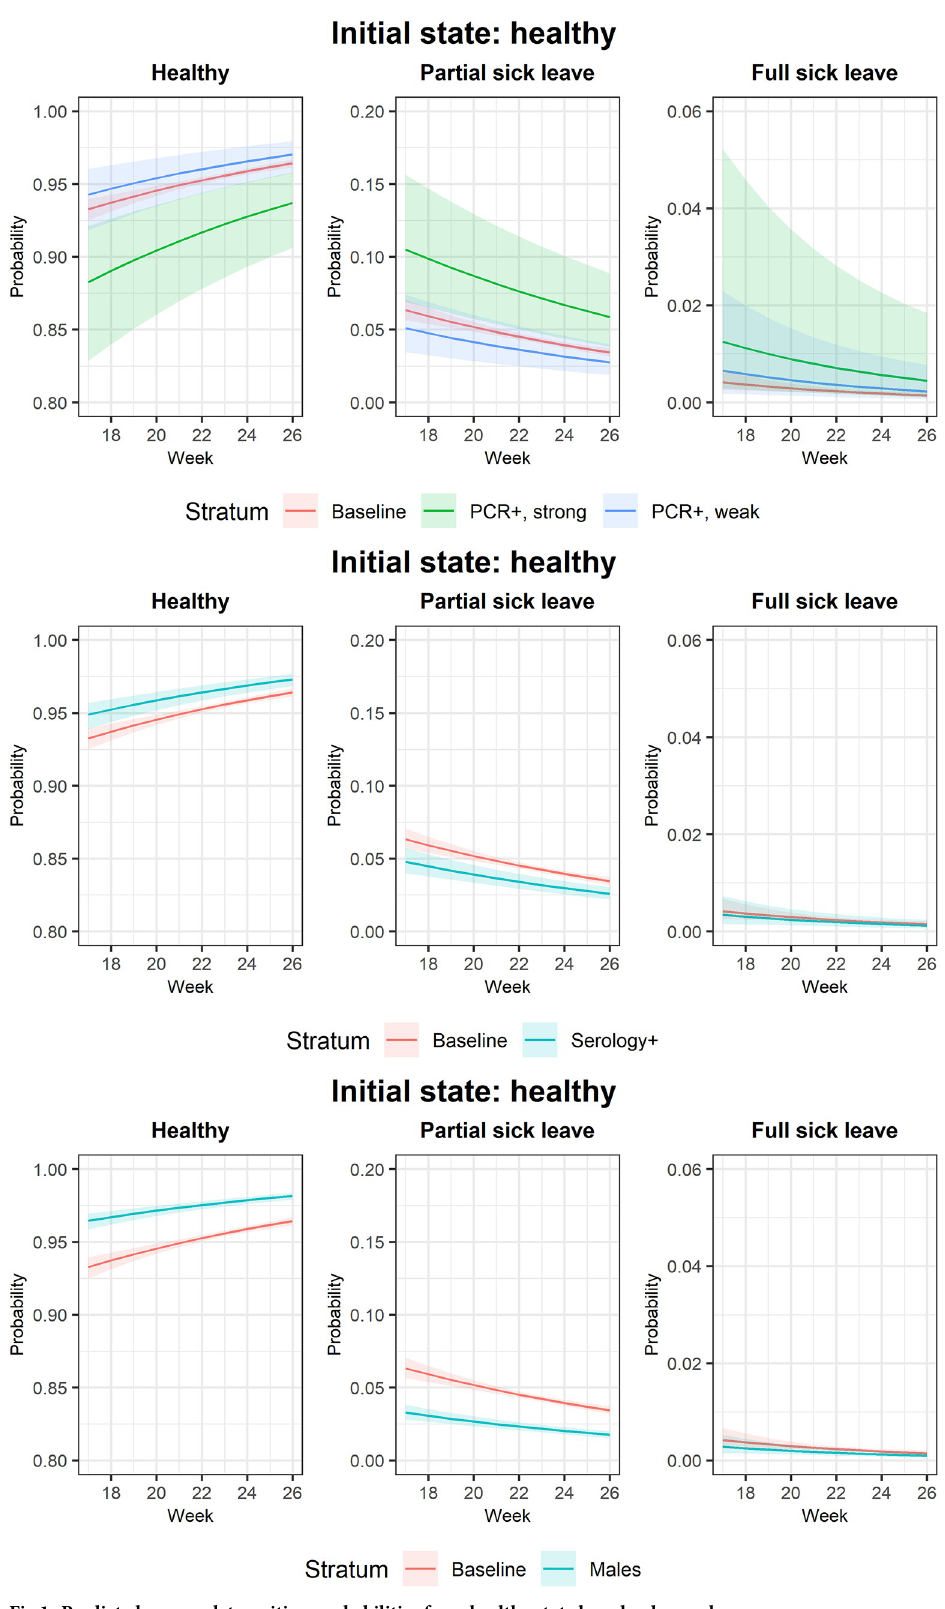
Fig 1. Predicted one-week transition probabilities from healthy state by calendar week. https://doi.org/10.1371/journal.pone.0273003.g001 PLOS ONE | https://doi.org/10.1371/journal.pone.0273003 August 12,